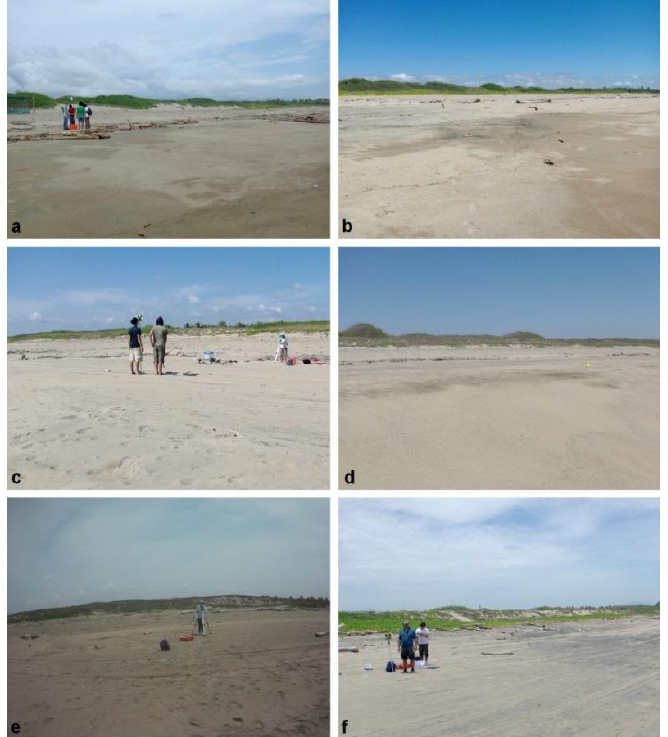
Figure 6. Vegetation cover on the foredunes in ( a ) September 2013, ( b ) November 2013, ( c ) January 2013, ( d ) March 2014, ( e ) May 2014, and ( f ) July 2014. The presence of high vegetation cover rates provided resistance and resilience to the dune-beach system when Hurricane Odile occurred.